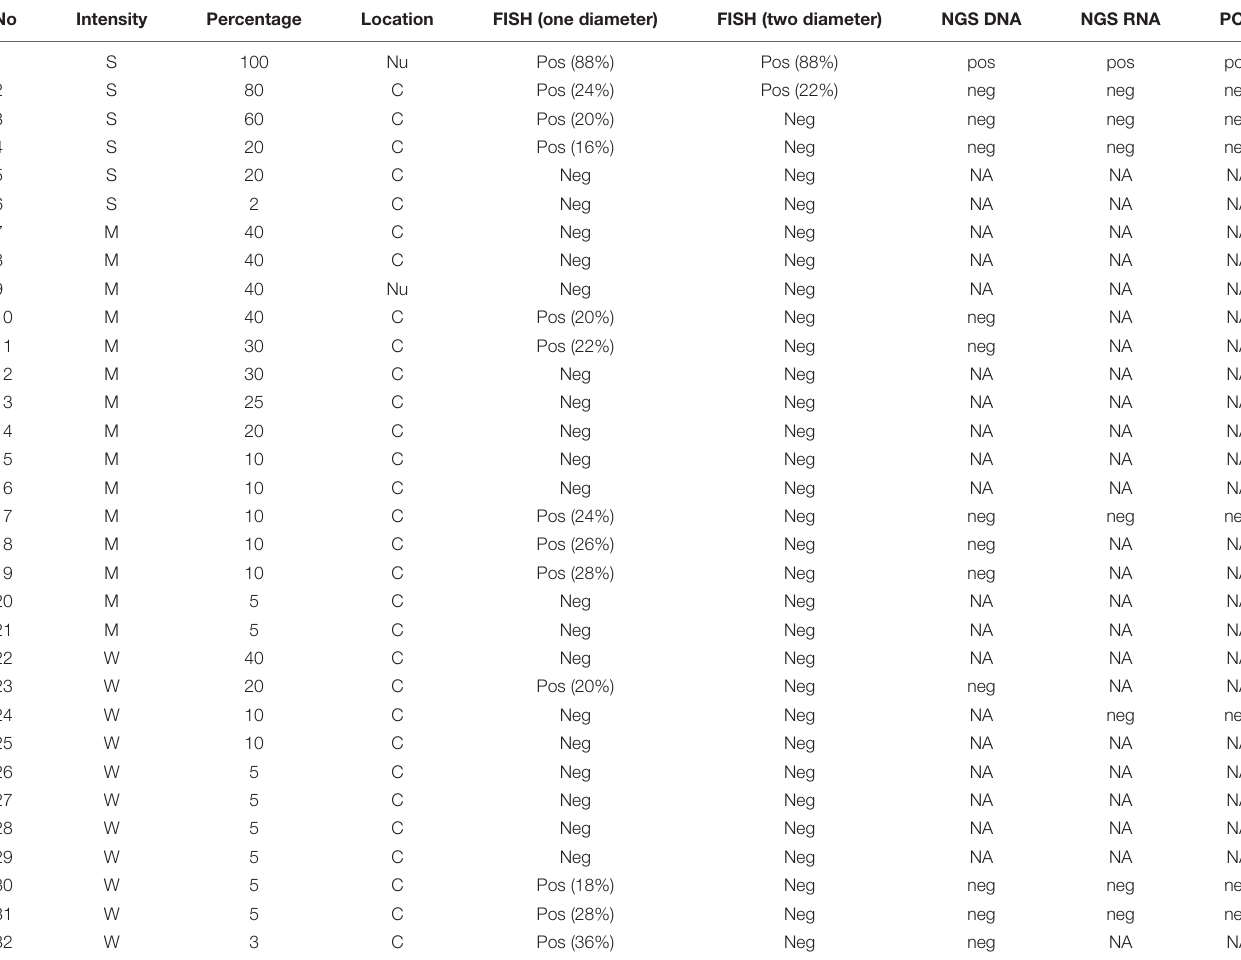
TABLE 2 | The detail information of the NTRK immunohistochemistry positive